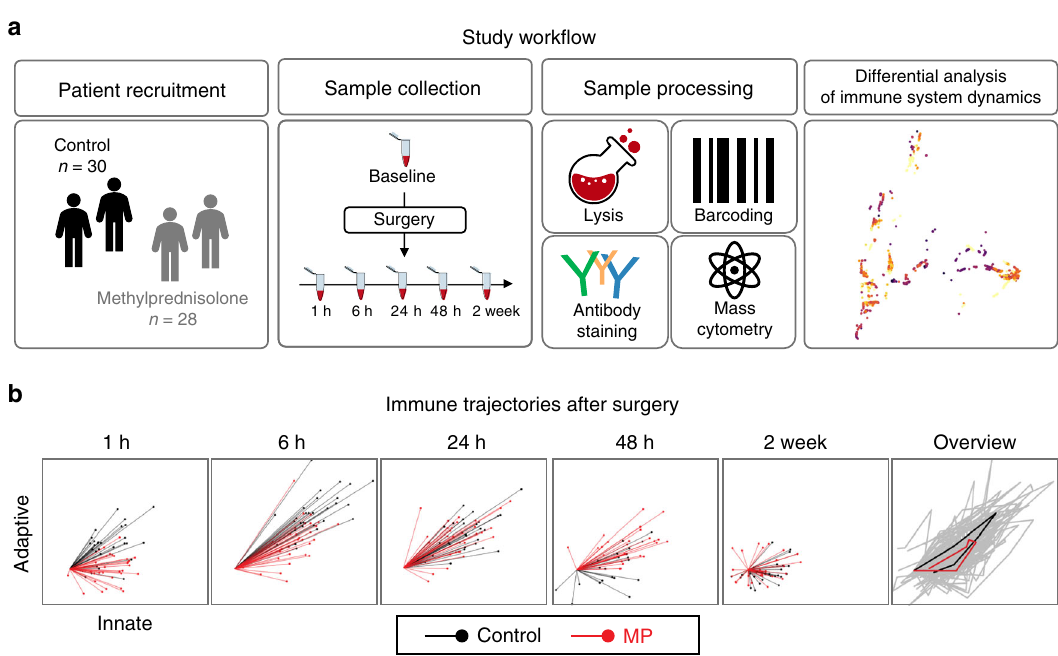
Fig. 1 Study work fl ow. a In a double-blind study, patients were randomized to receive a single preoperative dose of 125 mg methylprednisolone (MP, n = 28 patients) or saline placebo ( n = 30 patients). Peripheral blood and clinical outcomes data were collected prior to surgery (baseline) and at the indicated time points after surgery. After erythrocyte lysis, peripheral immune cells were barcoded, stained with cell-phenotyping and intracellular cell-signaling antibodies, and analyzed by mass cytometry. Unsupervised bootstrapped clustering of immune cell subsets followed by random forest analysis was performed to identify differential immune cell dynamics in MP vs. control groups. b A non-linear dimensional reduction algorithm (Isomap) showing individual patients ’ immunological trajectories after surgery along the innate (X) and adaptive (Y) axes (MP in red, control in black). Snapshots are shown for the 1 h, 6 h, 24 h, 48 h and 2 wk time points (animated trajectories can be found in Supplementary Movie 1). Right panel. Overview of median trajectories for the MP and control groups are shown in red and